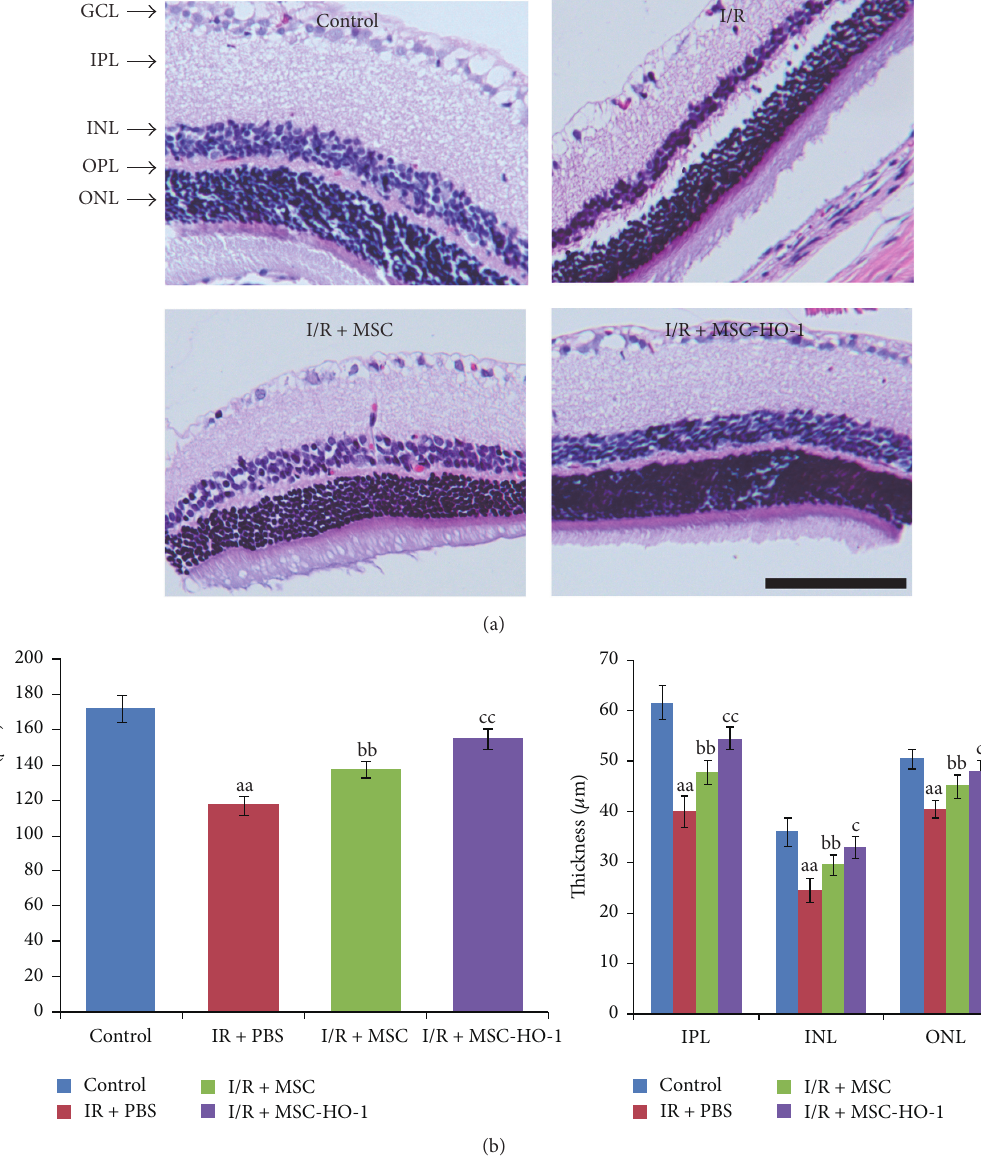
Figure 4: Effects of MSC-HO-1 on retinal histology at 21 days after I/R injury. (a) Representative retinal section images of control, I/R + PBS, I/R + MSC, or I/R + MSC-HO-1 group were achieved by H&E-staining. (b) The thickness of total retina (from the inner limiting membrane to the pigment epithelium), the inner plexiform layer (IPL), the inner nuclear layer (INL), and the outer nuclear layers (ONL) was investigated in the eyes of control, I/R + PBS, I/R + MSC, or I/R + MSC-HO-1 group, respectively ( 𝑛 = 5 ). aa 𝑃 < 0.01 compared with control group; bb 𝑃 < 0.01 compared with IR + PBS group; cc 𝑃 < 0.01 compared with IR + MSC group; c 𝑃 < 0.05 compared with IR + MSC